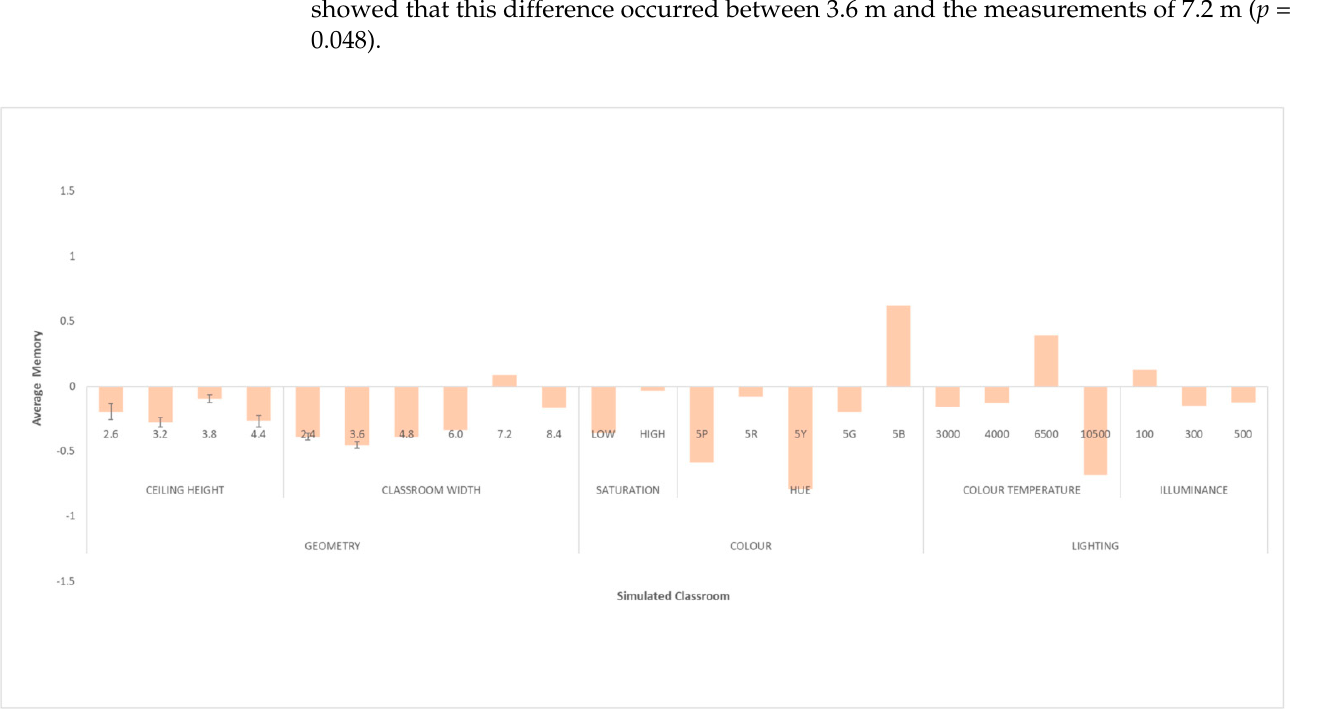
Figure 5. Average level of presence for each simulated classroom.